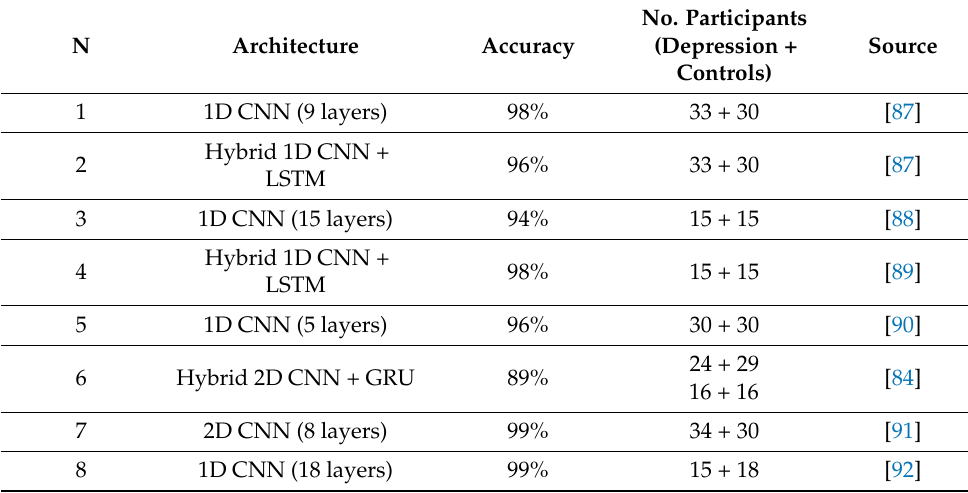
Table 3. EEG classification accuracy for depressive